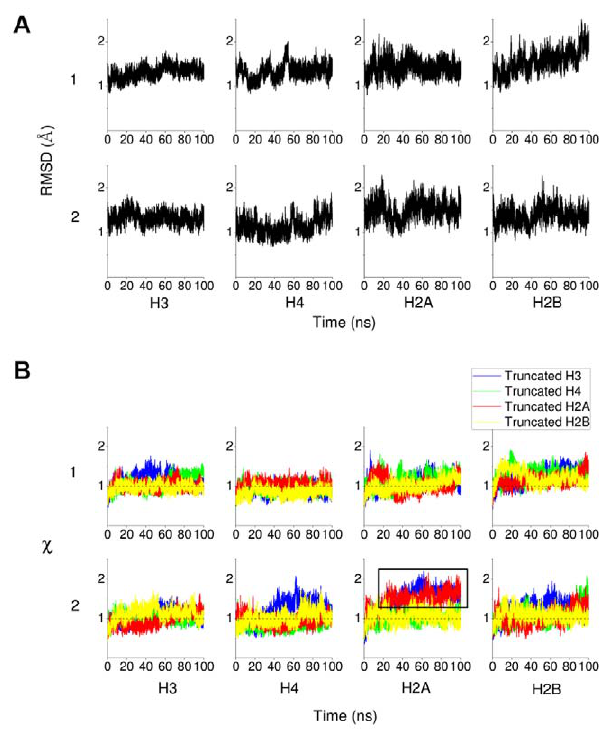
Figure4.RMSDandorderparameter x ofhistonemonomersH3,H4, H2A and H2B. (A) RMSDs for each of the two copies, 1 and 2, of the histone